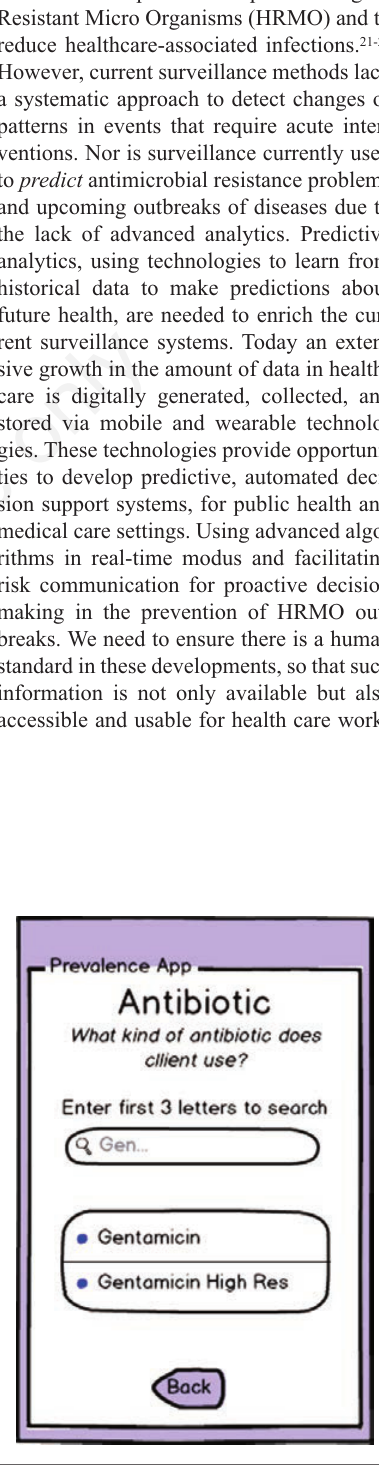
Figure 3. The Antibiotic Information app to support nurses in Antimicrobial Stewardship Programs. 17